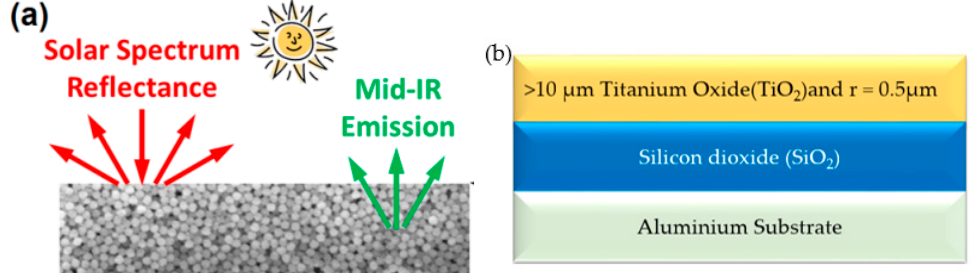
Figure 23. ( a ) Paint-format microsphere-based photonic random media [69] and ( b ) double-layer coating composed of TiO 2 and SiO 2 on a Silver substrate [26].